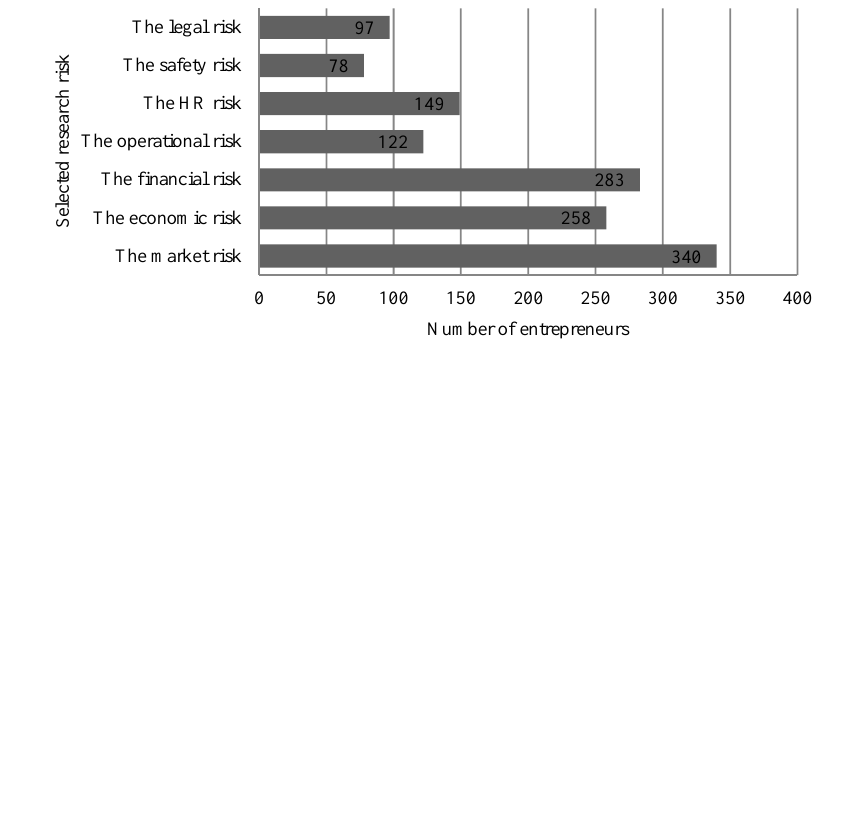
Figure 1. The key risks of the business